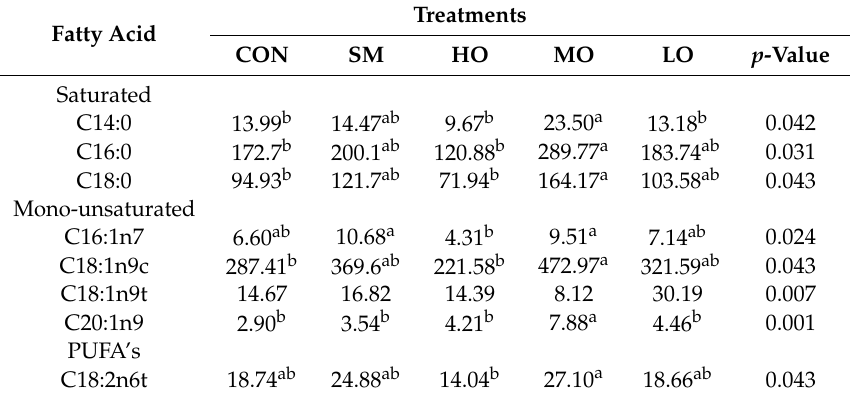
Table 2. Concentration of fatty acids (mg / kg of muscle) in total fat of Longissimus lumborum of male lambs a ff ected by supplementation of three di ff erent levels (HO = 0.4 g / kg DM; MO = 0.3 g / kg DM; LO = 0.2 g / kg DM) of oregano essential oils or monensin (SM) at commercial doses vs. a control diet